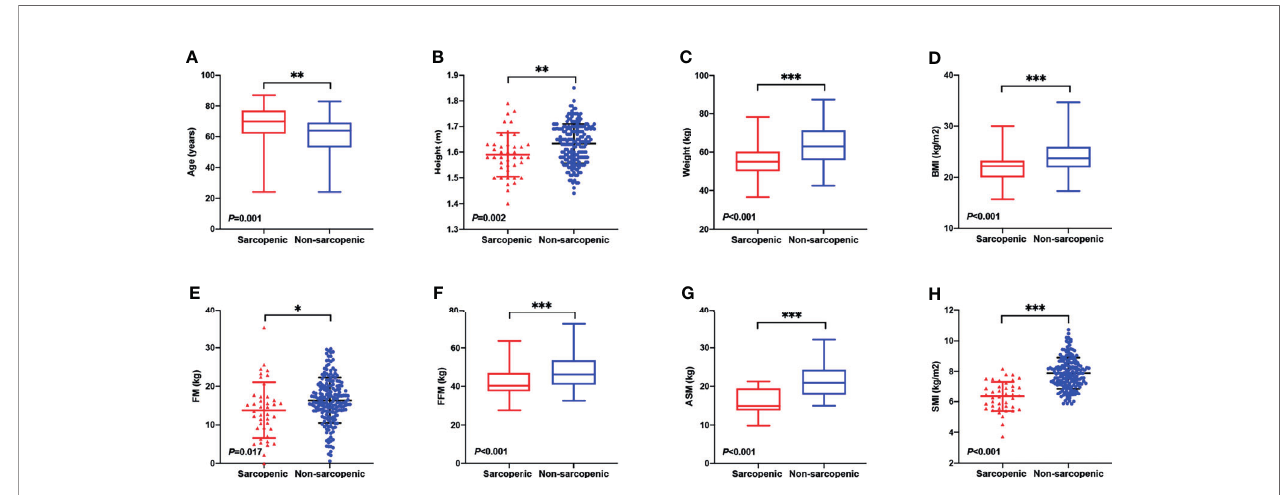
FIGURE 1 | Differences in body composition and demographic indicators between sarcopenic and non-sarcopenic patients. (A) The median age of the sarcopenic group was signi fi cantly greater than the non-sarcopenic group (median 70 vs. 64 years, P = 0.001). Sarcopenic patients showed signi fi cantly less (B) height (mean 1.59 vs. 1.63 m, P = 0.002), (C) weight (median 55.0 vs. 63.0 kg, P < 0.001), (D) BMI (median 22.2 vs. 23.8 kg, P < 0.001), (E) FM (mean 13.8 vs. 16.4 kg, P = 0.017), (F) FFM (median 40.3 vs. 46.2 kg, P < 0.001), (G) ASM(median 15.0 vs. 20.9 kg, P < 0.001),and (H) SMI (mean 6.4 vs. 7.9 kg/m2, P < 0.001)than the non-sarcopenic ones. BMI, Body Mass Index; FM, Fat Mass; FFM, Fat-free Mass; ASM,Appendicular Skeletal MuscleMass; SMI, SkeletalMuscle Index. *P < 0.05, **P < 0.01, ***P <